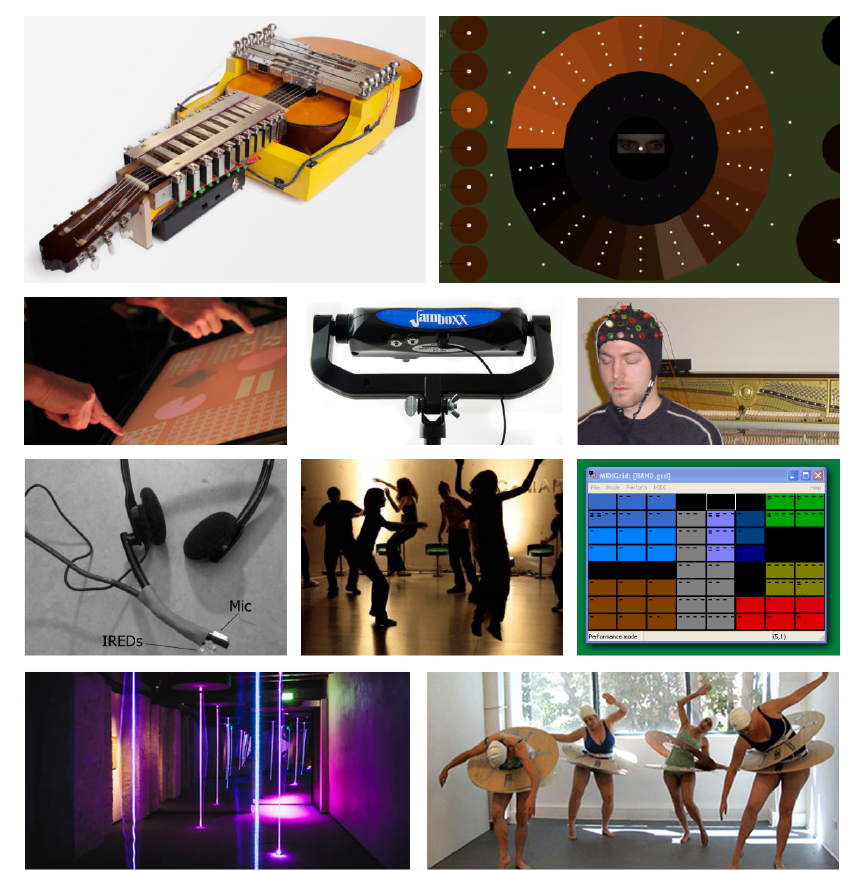
Figure 5. Examples of different control interfaces. Top row: Left: GuitarMasheen , an adapted instrument in the form of an electro-mechanically actuated guitar, by Dave Meckin [73]. Right: GUI of the EyeHarp , a gaze controller [42]. Second row: Left: MusicAid , a touchscreen controller [74]. Middle: Jamboxx Pro , a mouth-operated controller [18]. Right: BCMI Piano , a Brain–Computer Music Interface [75]. Third row: Left: The Flote , an audio controller [76]. Middle: Sound=Space installation, a touchless interface by Rolf Gehlhaar [77]. Right: MidiGrid , a mouse-controlled musical interface [78]. Last row: Left: Sound Forest , a music installation with tangible controllers in the form of interactive strings [79]. Right: HipDiskettes , a performance ensemble interacting with wearable HipDisk controllers